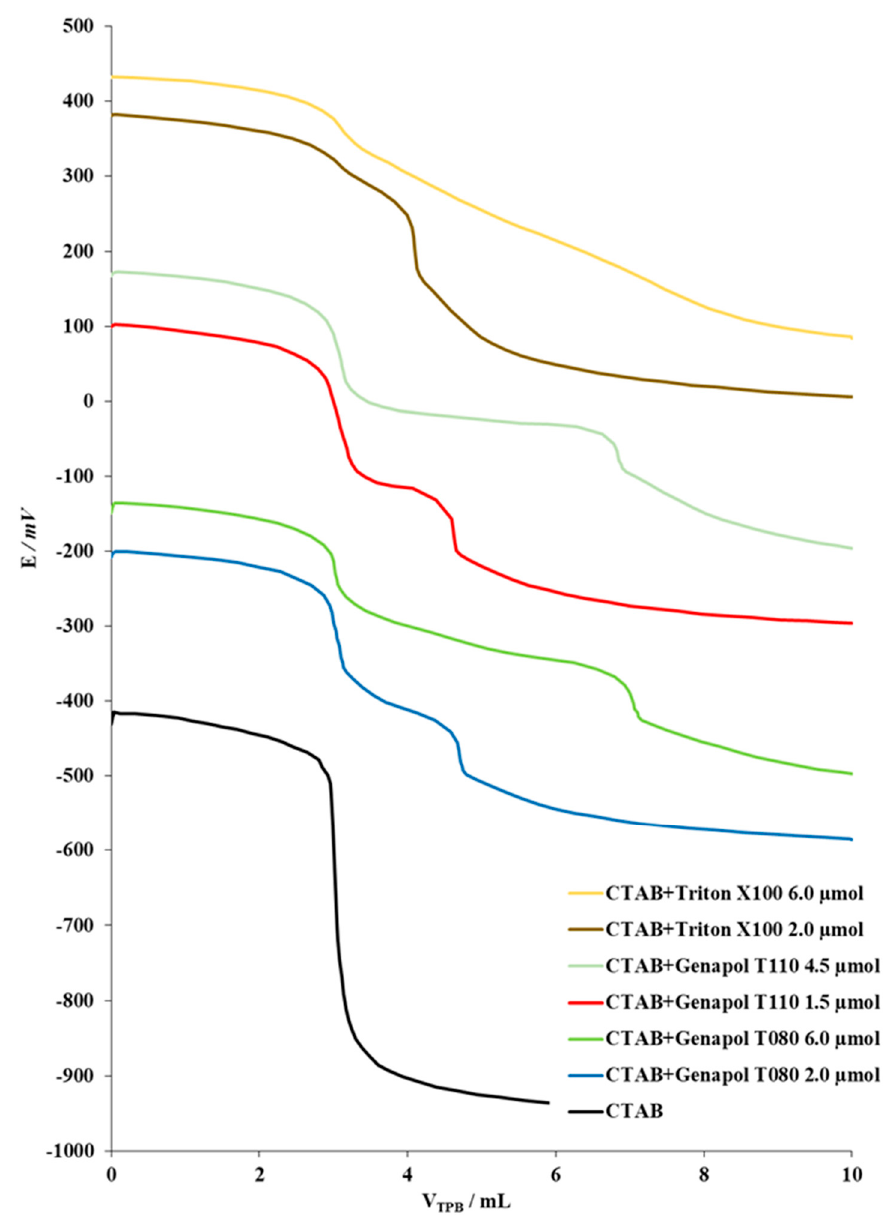
Figure 3. The influence of quantity and number of EO groups for the three EO-nonionic surfactants on the direct potentiometric titration curves of cationic surfactant CTAB (2.5 × 10 − 3 M) and selected EO-nonionic surfactants with TPB (2.5 × 10 − 3 M), in Ba 2+ (0.2 M) using the DHBI–TPB surfactant sensor as the end-point detector. The titration curves for corresponding formulations of EO-nonioinic surfactant and CTAB were rearranged in order of appearance for clarity, from the bottom up: a) only CTAB; b) CTAB with Genapol T080 2.0 µmol; c) CTAB with Genapol T080 6.0 µmol; d) CTAB with Genapol T110 1.5 µmol; e) CTAB with Genapol T110 4.5 µmol; f) CTAB with Triton X100 2.0 µmol and g) CTAB with Triton X100 6.0 µmol.